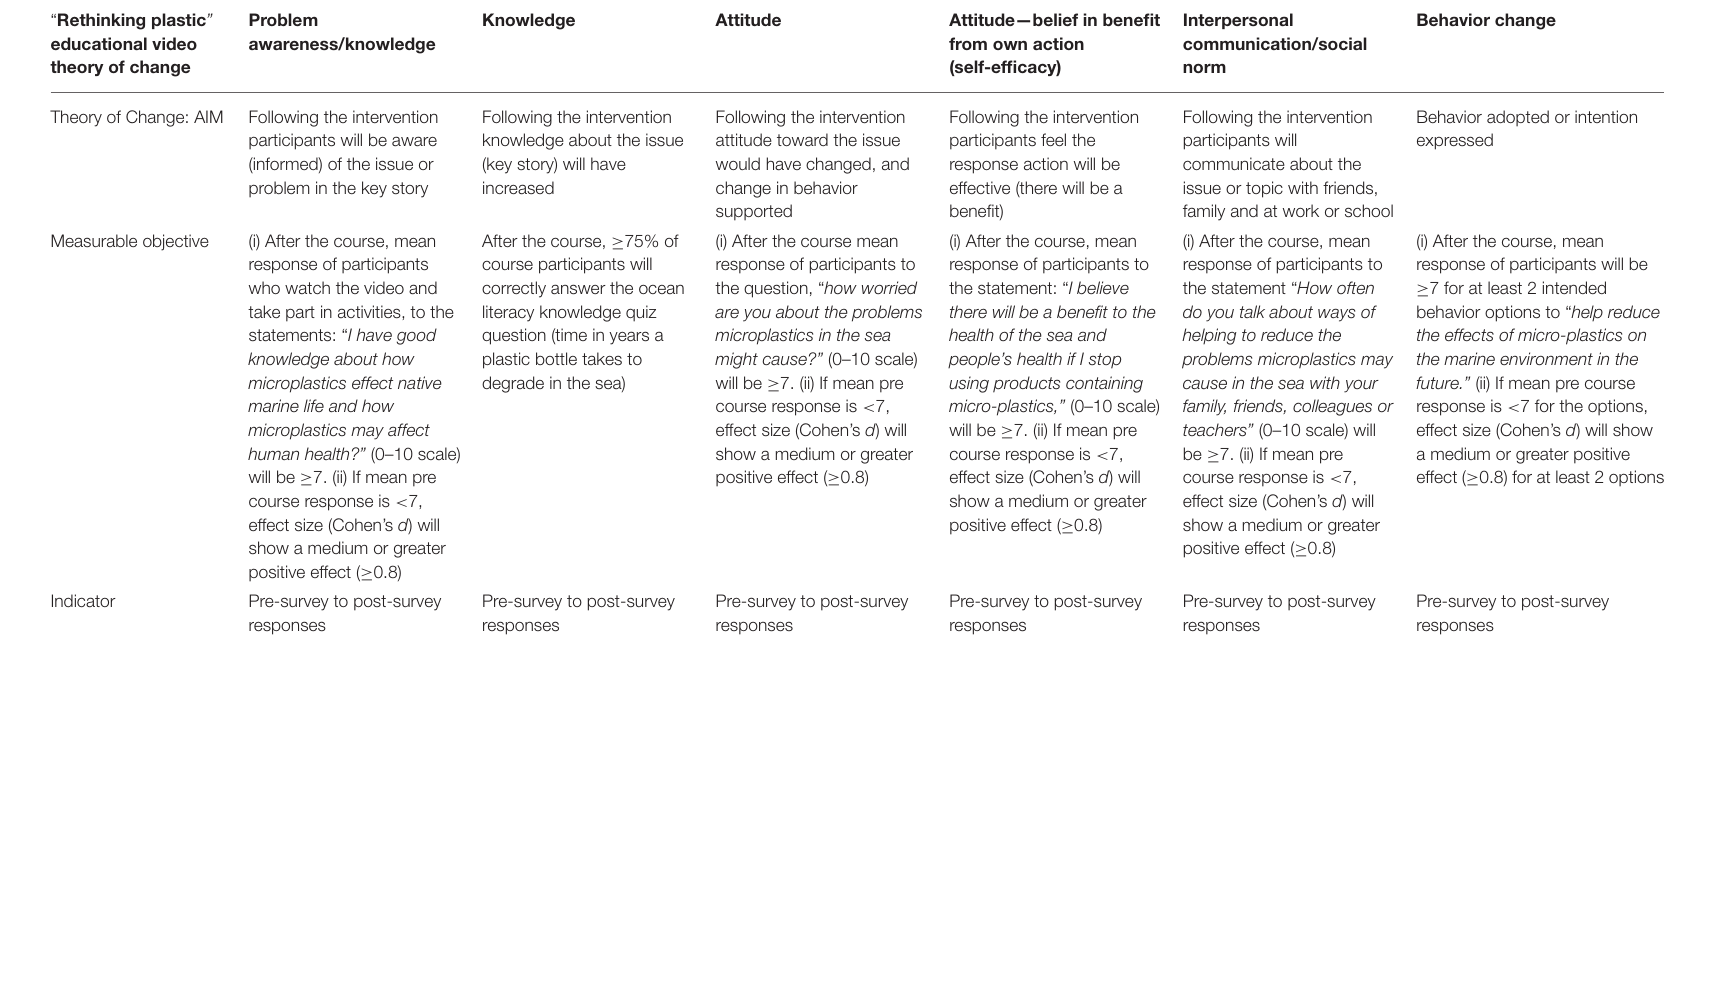
TABLE 4 | Theory of Change model for the educational videos presented within workshops for school pupils (aged